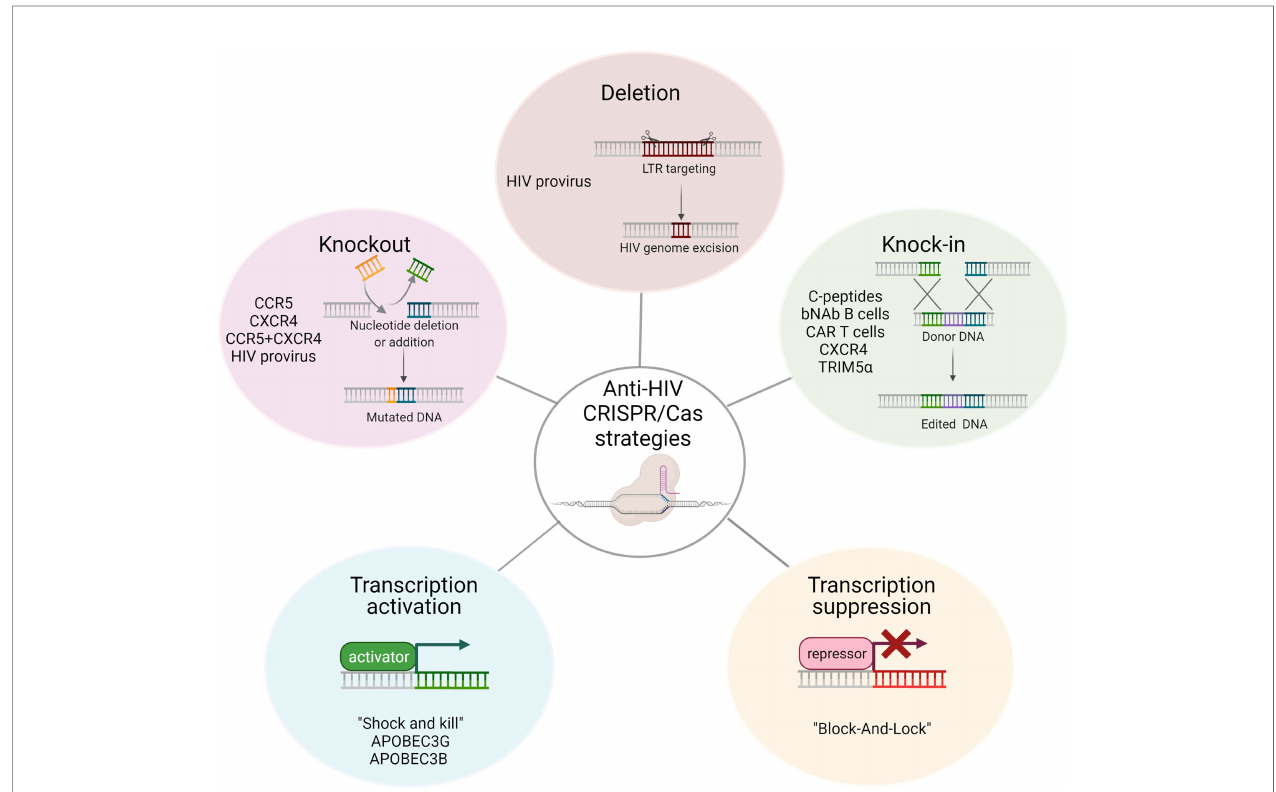
FIGURE 1 | A fl owchart showing CRISPR/Cas anti-HIV approaches used to protect cells from HIV infection. Depending on the gene-editing techniques (shown on top of each block) and cellular or viral genes selected for targeting (shown below) they were divided into fi ve groups. Some strategies may overlap. For example, gene knockout or provirus deletion can be accompanied by targeted integration of a therapeutic gene; all of them are inheritable and effects are stable in comparison to CRISPR-based transcription regulation. This image was created with